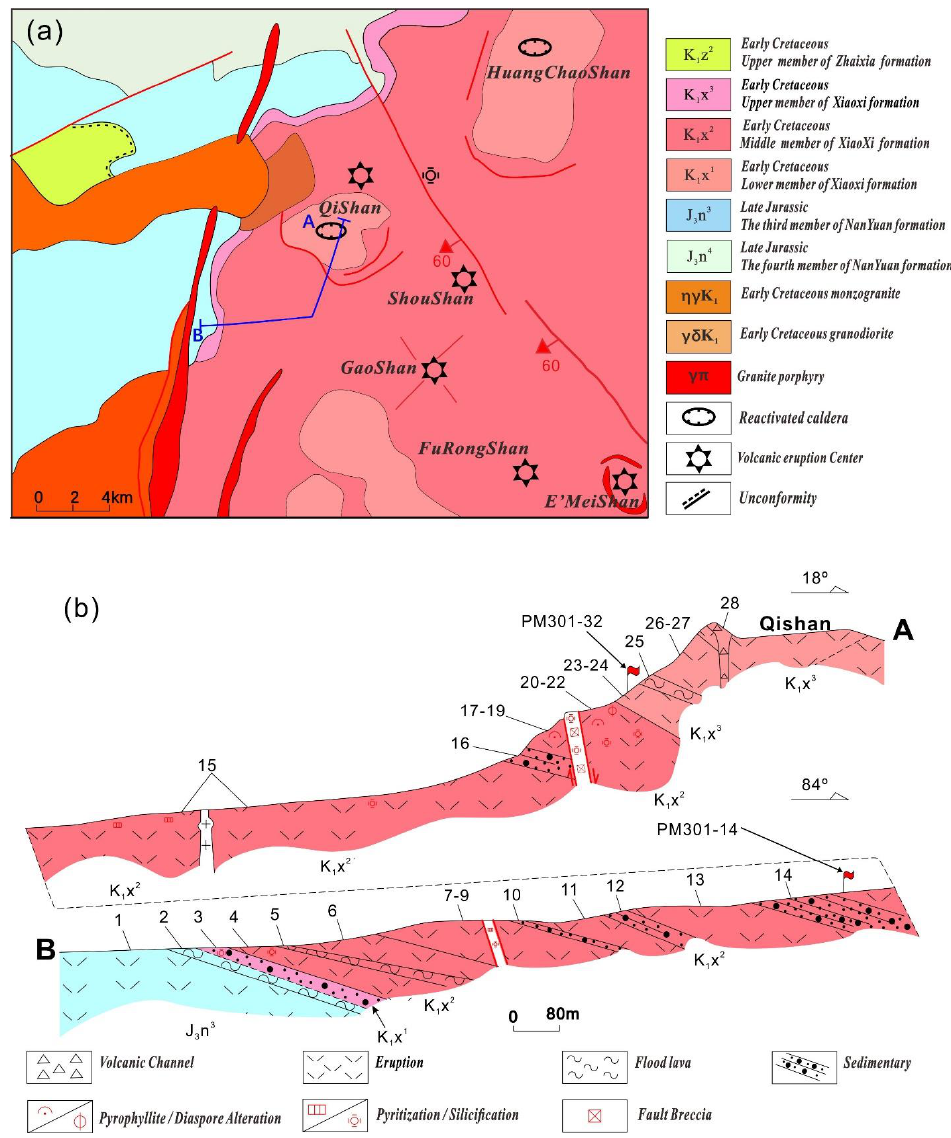
Figure 3. ( a ) Geologic sketch map of the northwestern Shoushan basin and investigated route of volcanic lithofacies of the Qishan caldera. ( b ) The stratigraphic section along the survey route.